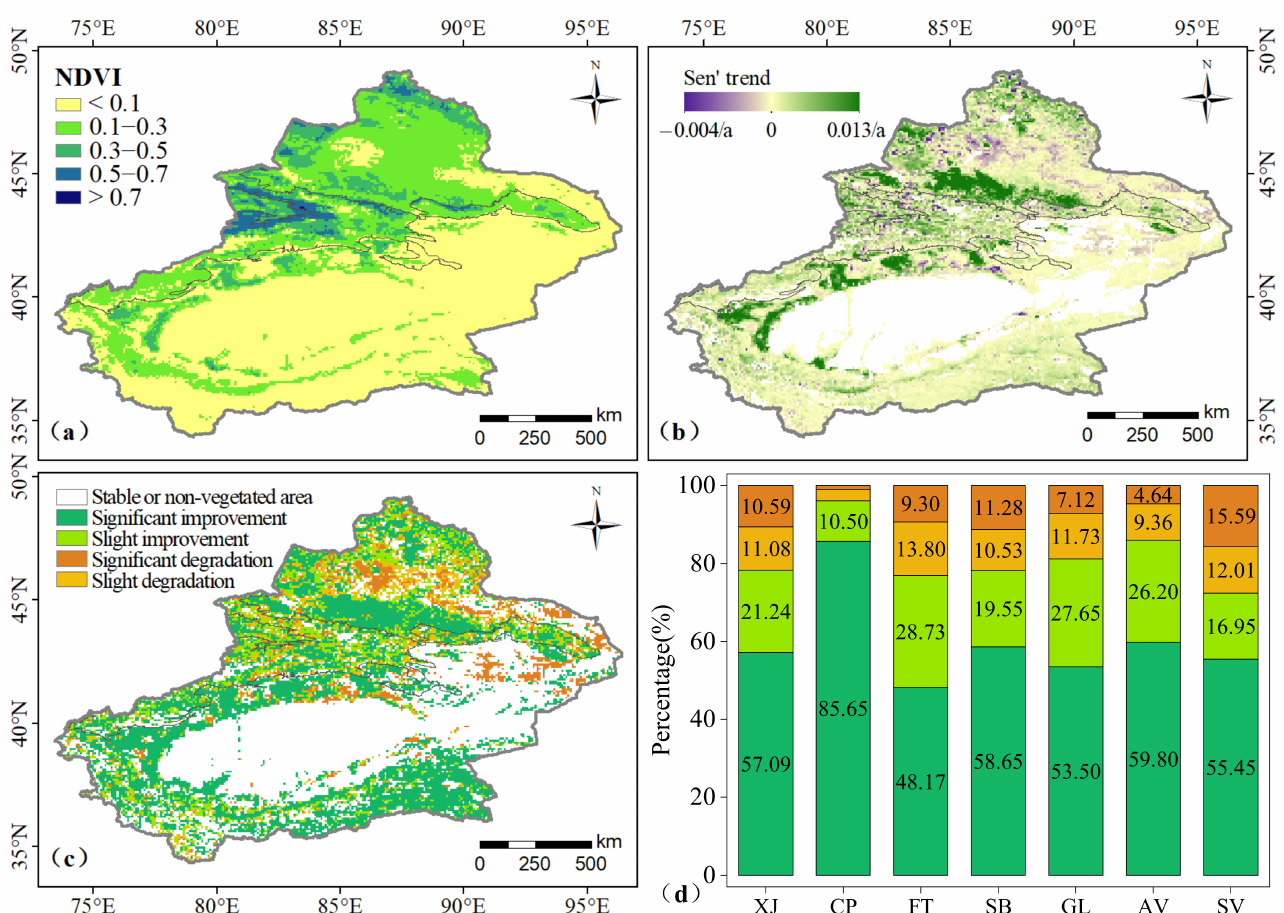
Figure 3. Changes in vegetation NDVI from 1982–2018. ( a ) Spatial patterns of average NDVI; ( b ) annual change trends; ( c ) types of change patterns and ( d ) percentage changes of NDVI for different vegetation types. The legend of ( d ) is the same as that of ( c ). XJ: Xinjiang; CP: crop; FT: forest; SB: shrub; GL: grassland; AV: alpine vegetation; SV: sparse vegetation.